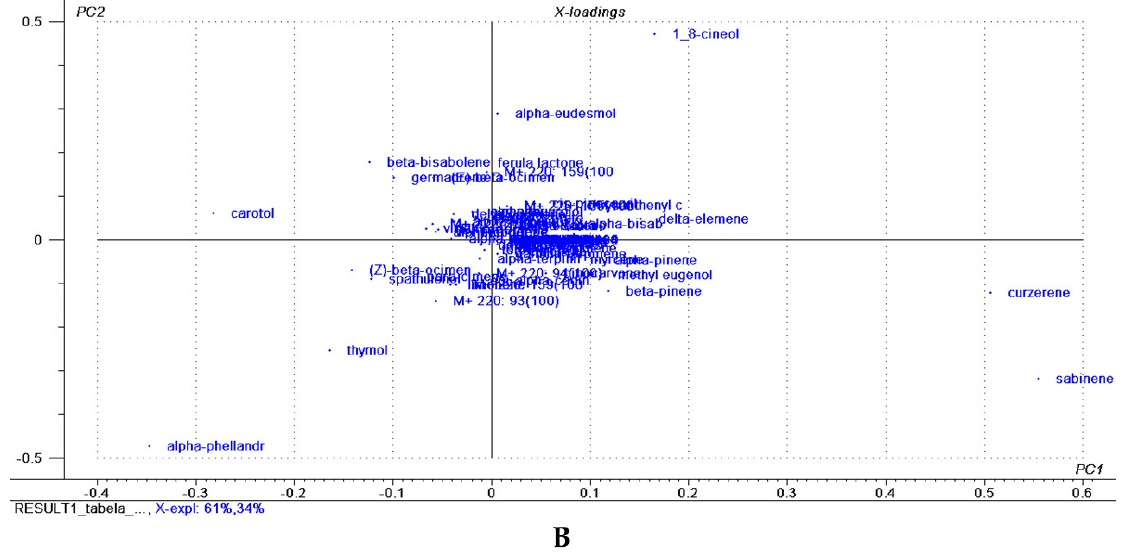
Figure 1. ( A ) Scores and ( B ) Loadings of Principal Component Analysis (PCA) of the chemical composition of Hedyosmum brasiliense essential oils; FF 1, 2, 3 = female flowers; FM 1, 2, 3 = male flowers; LF l, 2, 3 = female leaves; LM l, 2, 3 = male leaves.